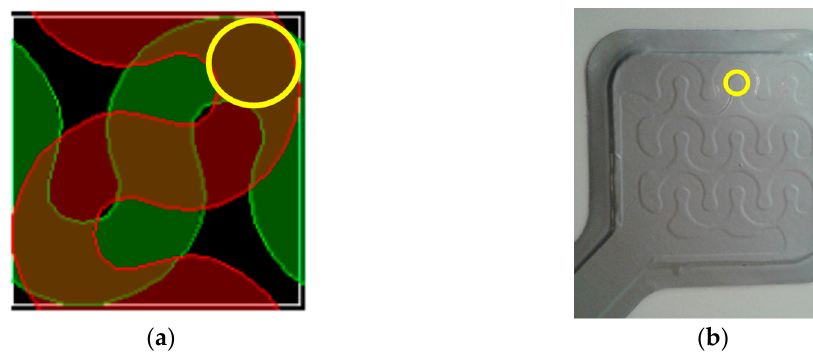
Figure 4. ( a ) Internal structure of a sensing element of the sensor XL S2004. The most active region, where two sensing elements are superimposed, is encircled in yellow; ( b ) External view of the sensor with the most active region encircled in yellow.